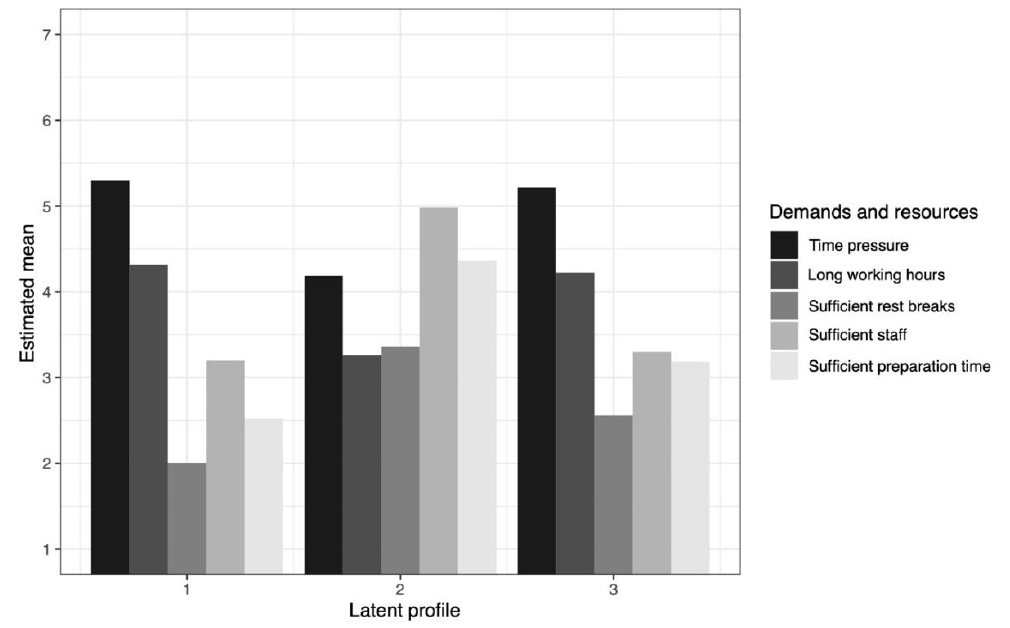
Figure 6. Latent profile solution for demands and resources (estimated means: time pressure, long working hours, sufficient rest breaks, sufficient staff and sufficient preparation time; 7-point Likert scales; 1= never to 7= always/every